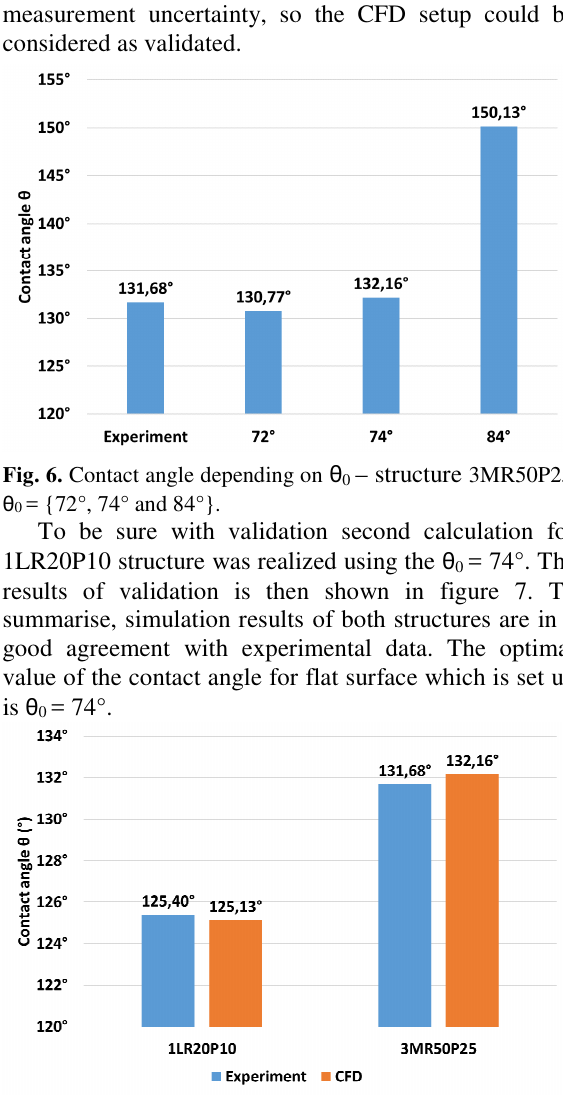
Fig. 7. Comparison between CFD results and experimental data – structures 1LR20P10, 3MR50P25 , θ 0 = 74°.